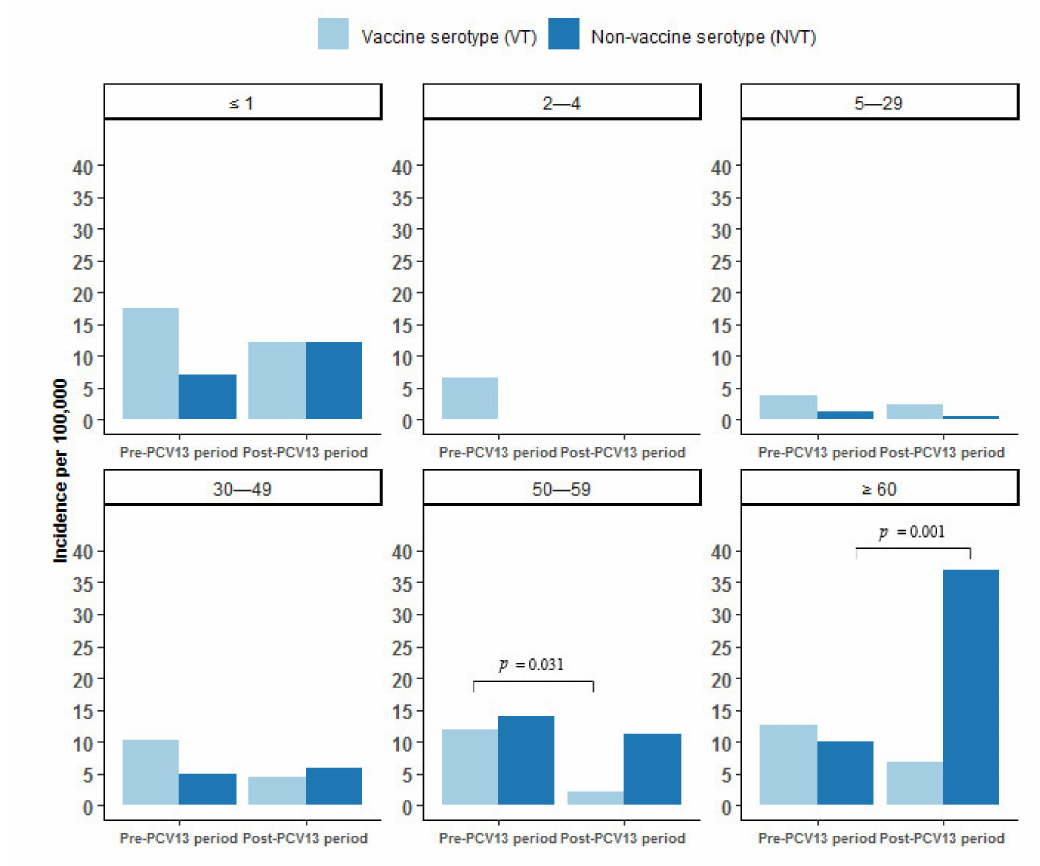
Figure 4. Incidence of invasive pneumococcal disease (IPD) per 100,000 person years by vaccine serotypes (VT) and non- vaccine serotypes (NVT) by age group in Greenland 1995–2020, overall, pre (1995–2010), and post (2010–2020) introduction of the 13-valent pneumococcal conjugate vaccine (PCV13) to the childhood vaccination program in 2010 in Greenland. Differences between the pre-PCV13 and the post-PCV13 periods are marked with a horizontal black line and denote statistical significance at the p < 0.05